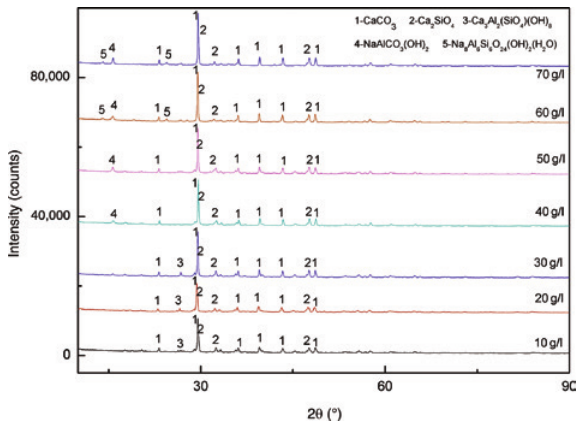
Figure 8: X-ray diffractograms of carbonated residues produced from NaOH solutions of different concentrations.